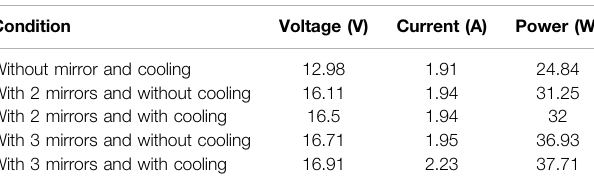
TABLE 3 | Voltage and current values with and without using mirrors and cooling (Arshad et al.,